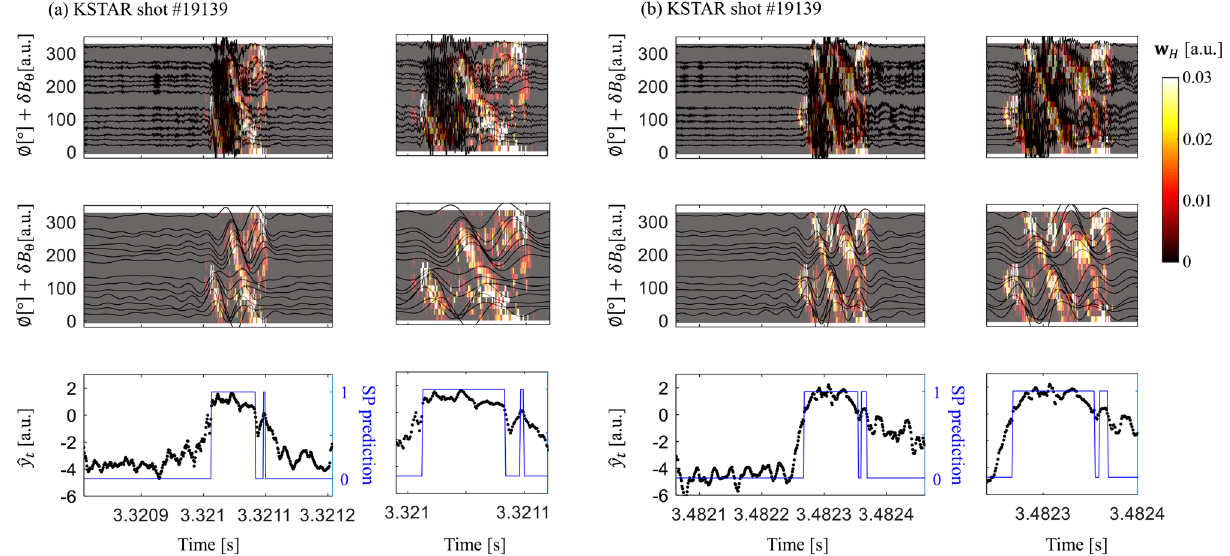
Figure 3. Validation of the final model using a gradient-based visualization technique. Heatmap of w H is overlaid on the MC raw signals (first row) and band-pass filtered MC signals (second row) for different sequences, ( a ) and ( b ). Third row represents the pre-sigmoid activation of the output ˆ y t (black dot) and prediction of SP existence (blue line). The figures on the right in ( a ) and ( b ) are enlarged figures of the area of interest in each example. The heatmap w H shows the influential part of the input area on the positive outputs. The heatmaps were generated using Matlab version R2018a (https ://www.mathw orks.com/) 31